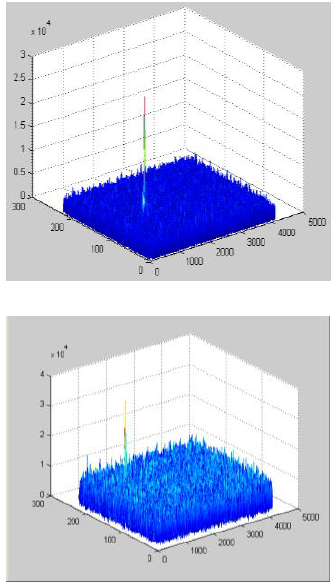
Figure4 : Signal acquisition correlation diagram